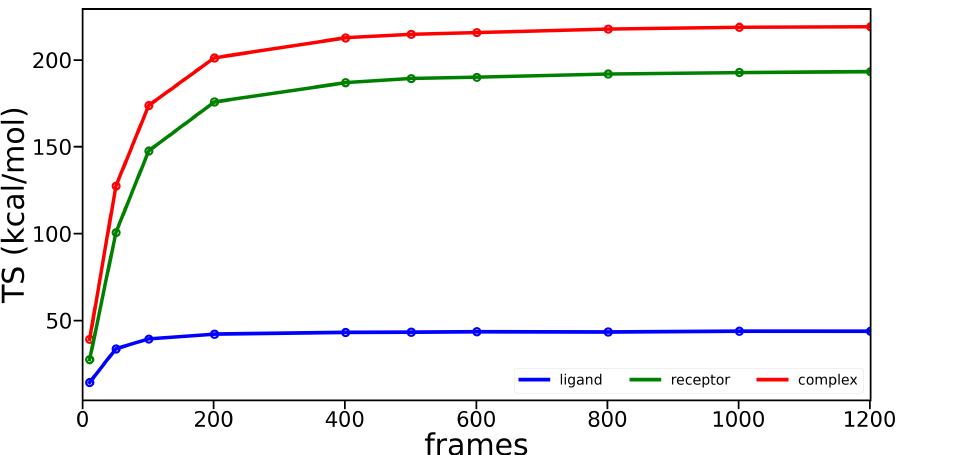
Figure A6. The value of the entropic contributions TS computed for Lig 9 , the receptor, and the Lig 9 -receptor complex based on the last 30 ns of the 50 ns simulation for a varying number of equally spaced simulation